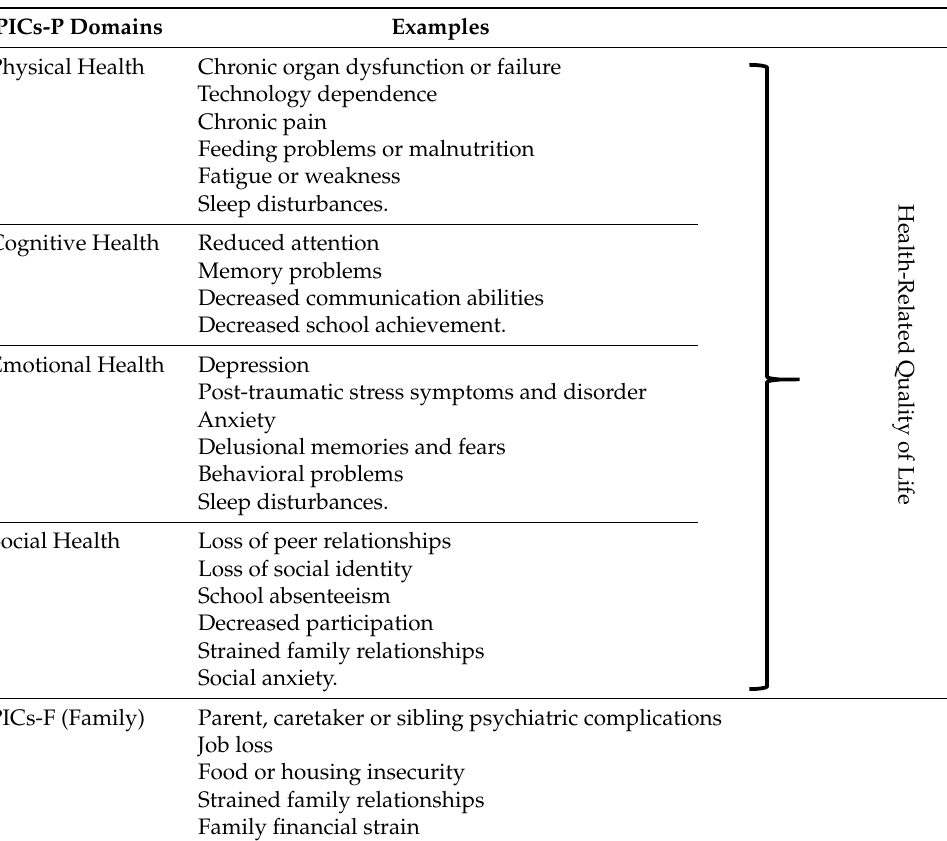
Table 1. PICs-P domains and selected examples of adverse outcomes in each domain. Listed examples are not comprehensive, and some examples can span multiple domains.